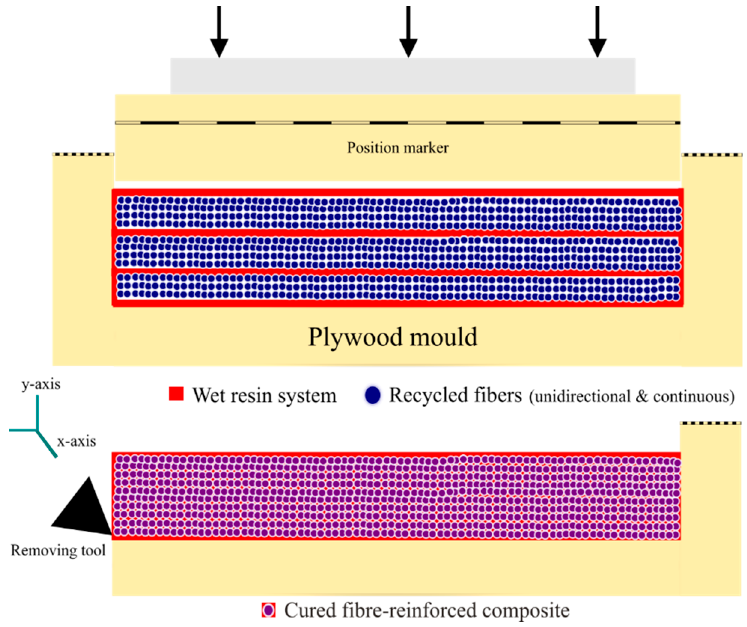
Figure 5. Compression moulding arrangement.